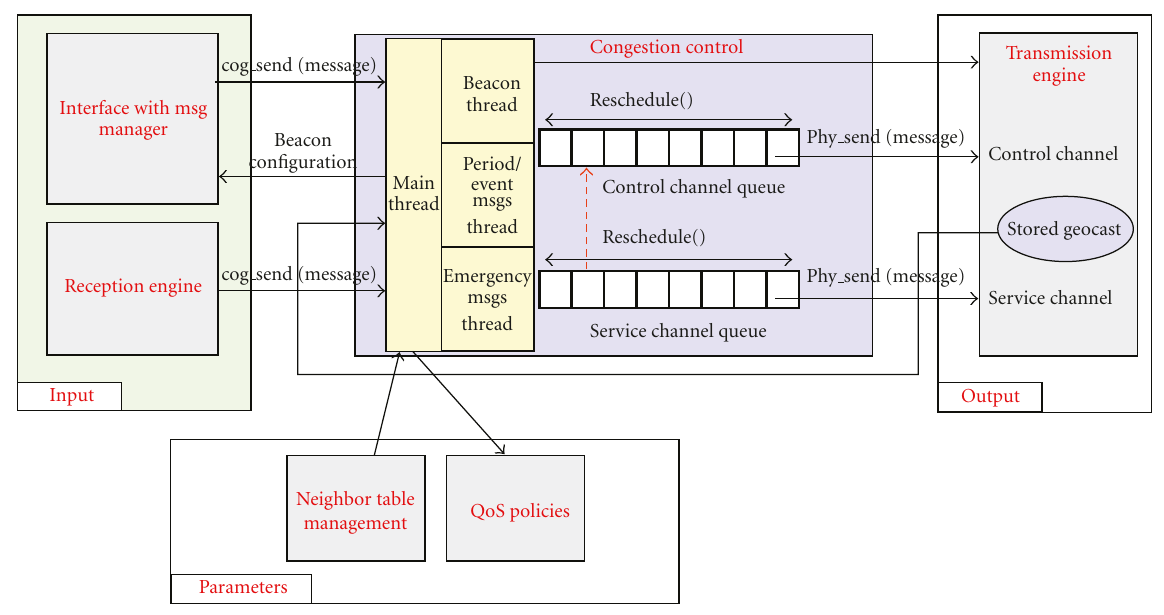
Figure 18: VANET Router